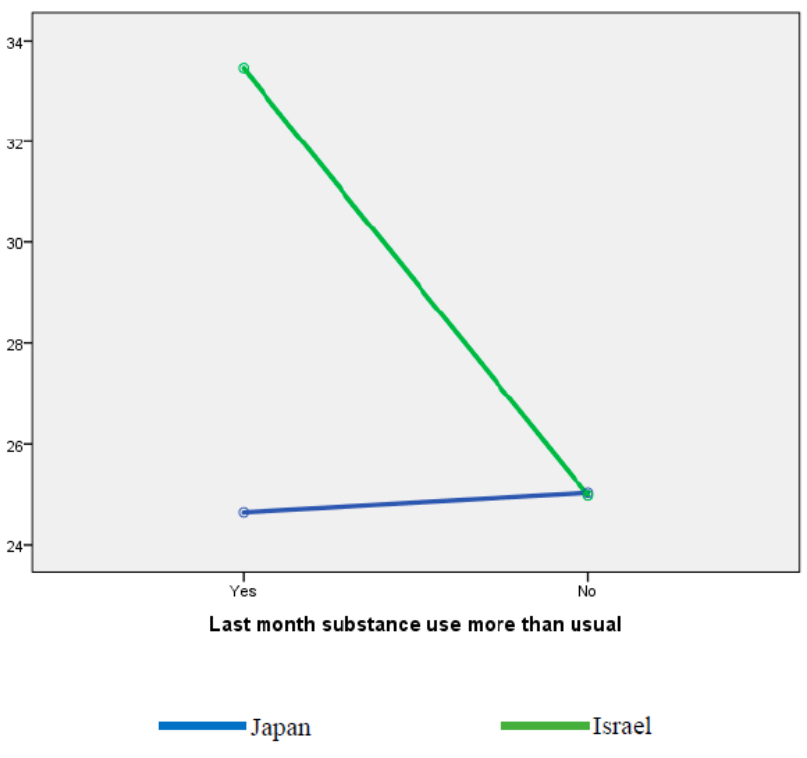
Figure 3. Economic concern by country and above-usual substance use in the previous month. Table 3. Substance use and psycho-emotional well-being by economic concern, economic well-being, resilience, and burnout.